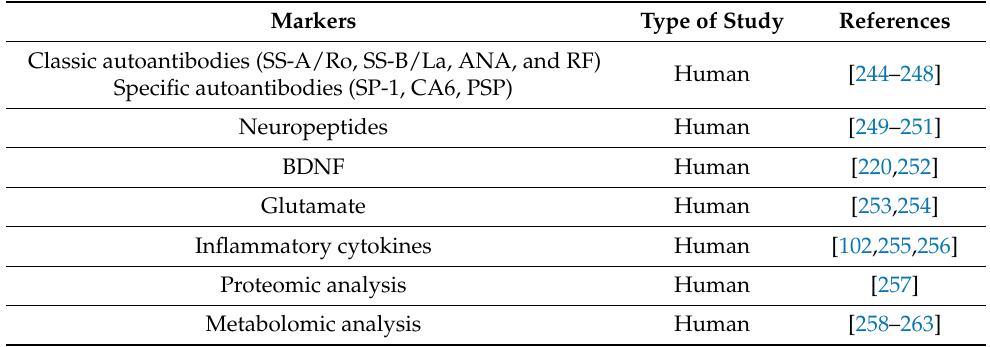
Table 2. Blood markers for FM diagnosis. Markers Type of